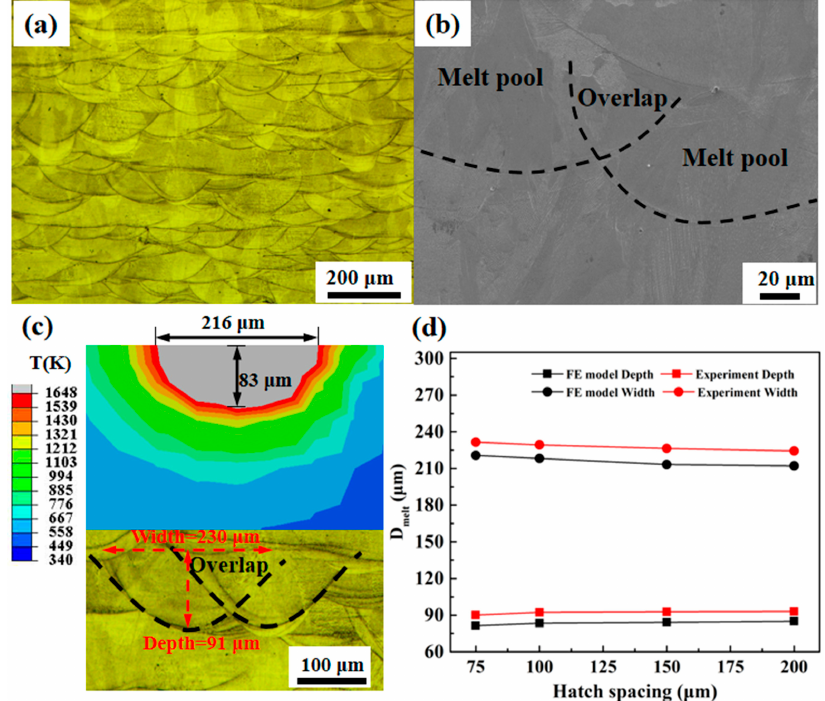
Figure 4. ( a ) Optical and ( b ) SEM representative images of the lateral section of the samples; ( c ) simulated (upper) and experimental (under) melt pool size for a hatch spacing of 100 µ m, and ( d ) the results of simulation and experimental: Width/depth of the melt pool for different hatch spacings.